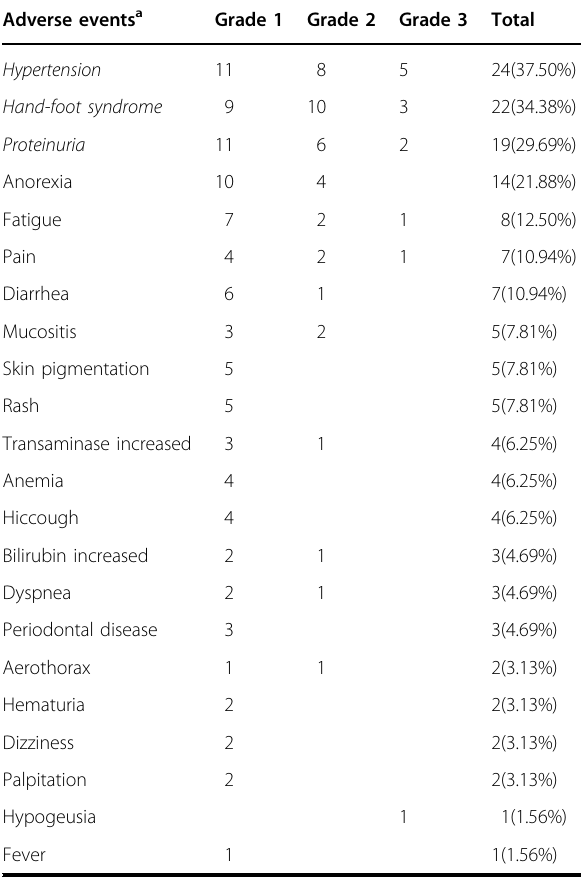
Table 3 Adverse events in 64 patients with sarcoma treated with